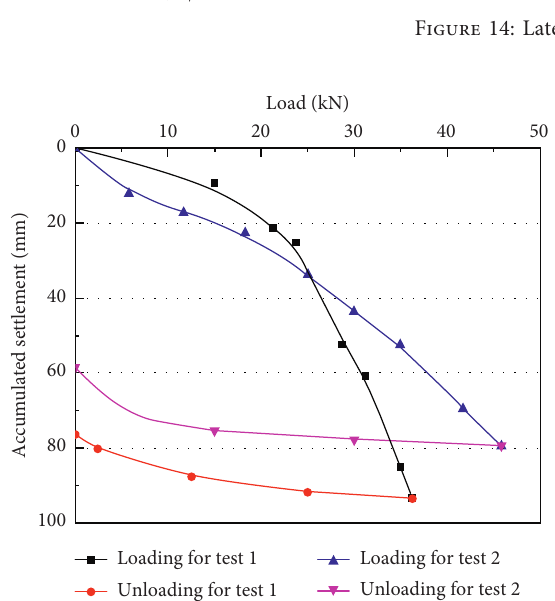
Figure 15: Accumulated settlement of single pile under vertical